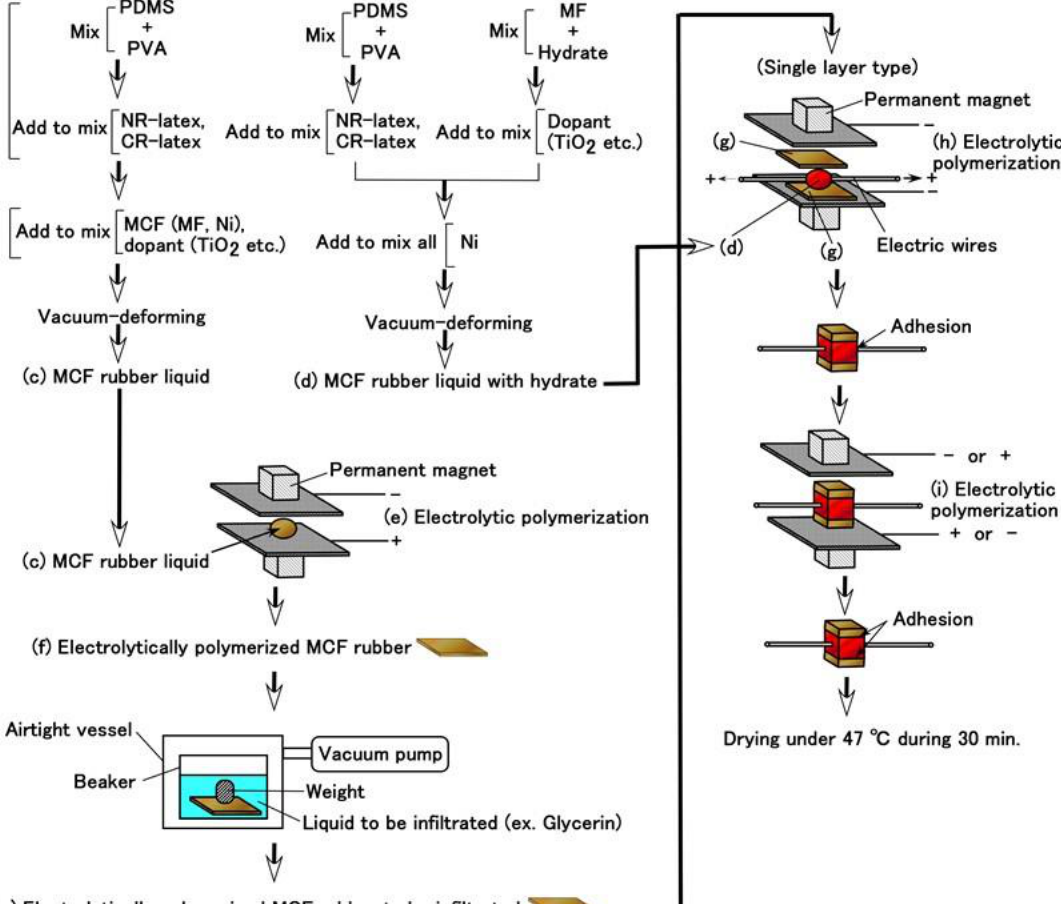
Figure 5. Procedure of the production of an MCF rubber sensor by combining PDMS and PVA.